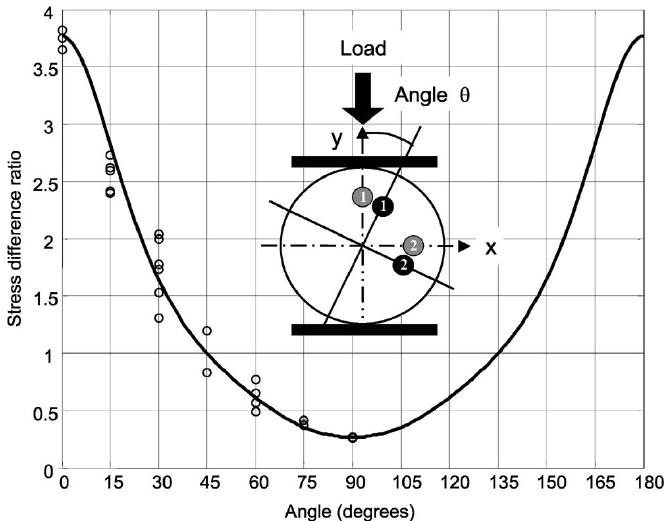
Figure 13. Theoretical curve (solid curve) and experimental data (points) for the stress difference ratio of two cores at 90 ◦ separation. Reprinted with permission from Ref. [45] © 2005 Optica Publishing Group.